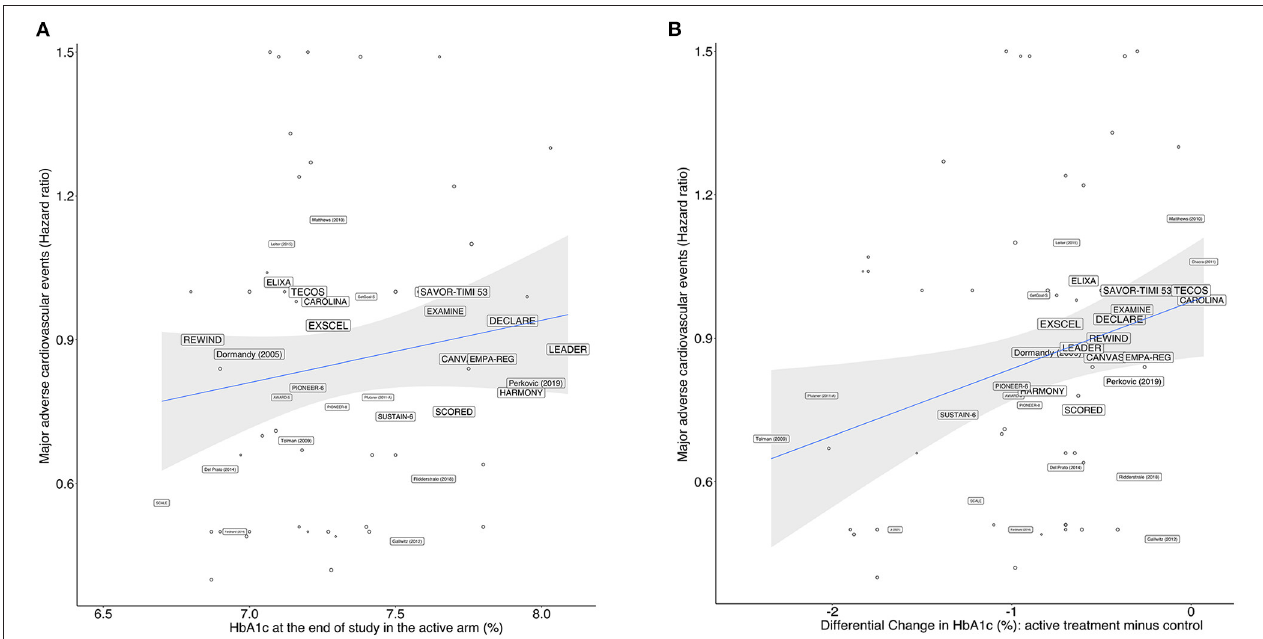
FIGURE 4 | Meta-regression model for all drugs showing the relationship between the HR for MACE vs.: (A) achieved HbA1c levels at study end in the active arms of each trial, and (B) differential change in HbA1c levels between active and control arms. The size of the trials’ name corresponds to their proportional weights in the